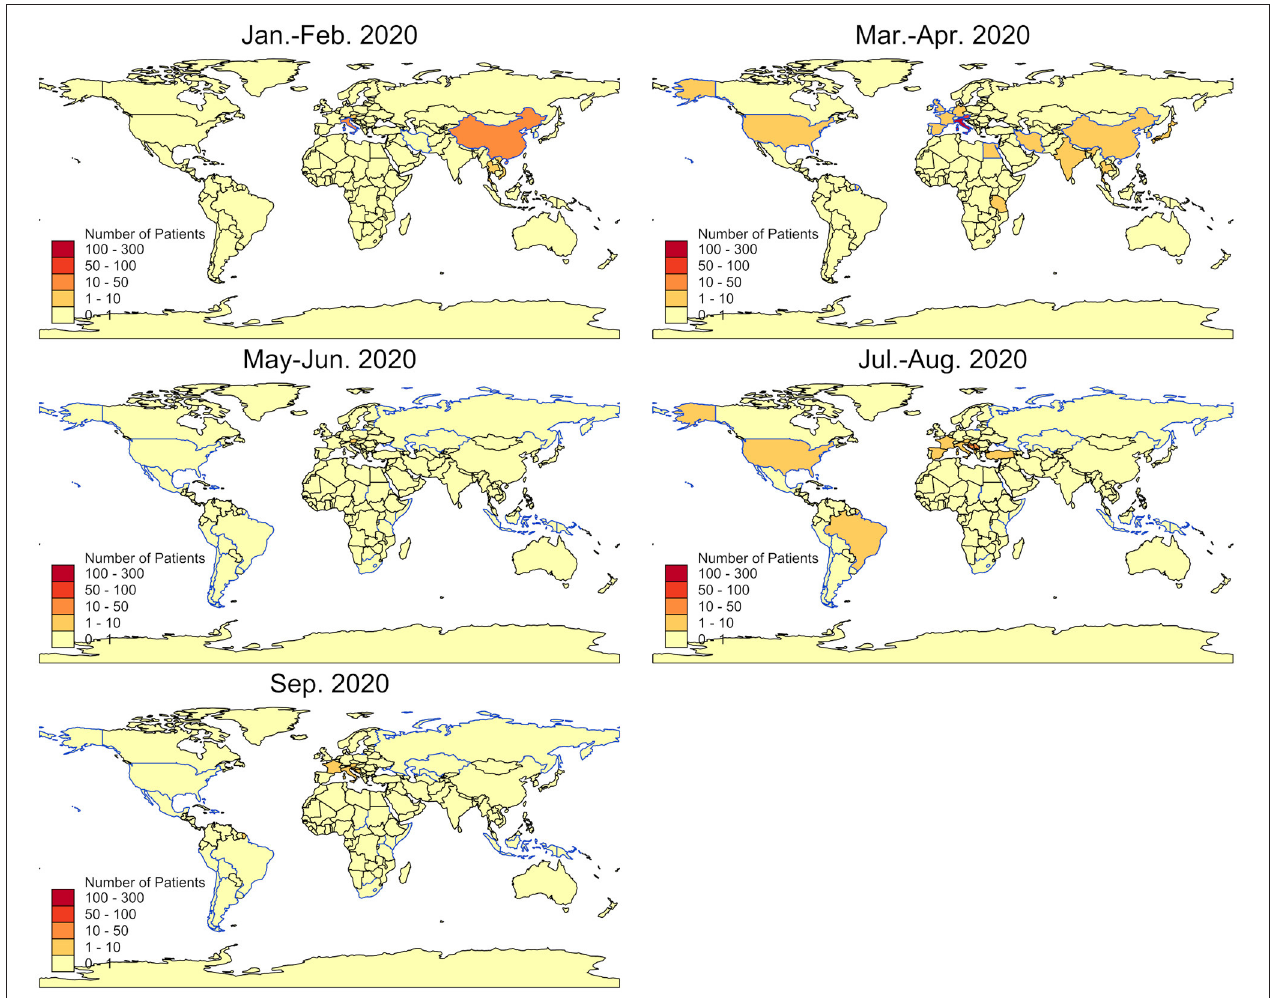
FIGURE 4 | Countries of reported travel history. Bimonthly numbers of travel returnees admitted to the CTU by country (colored areas) and risk countries as by RKI (blue